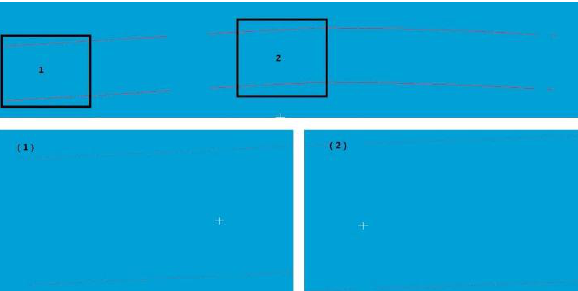
Figure 5. Rough segmentation